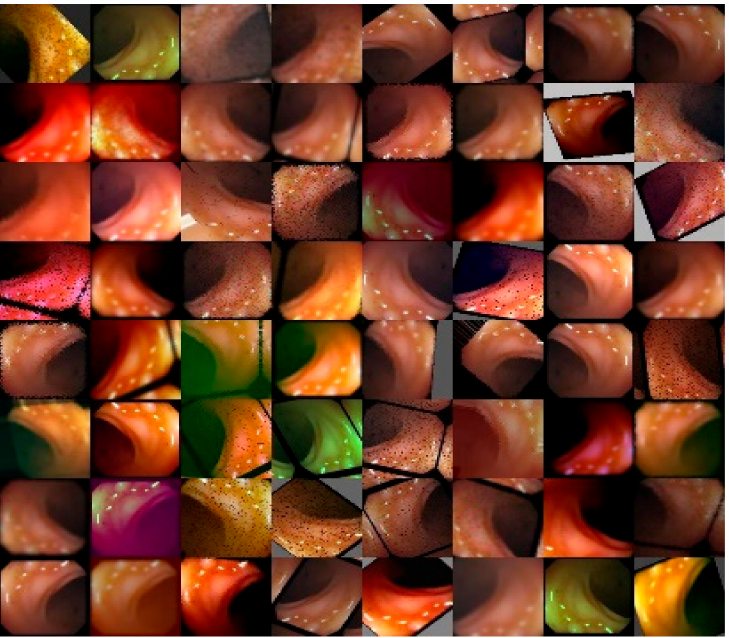
Figure 4. One image of colon polyp after applying different image augmentations.